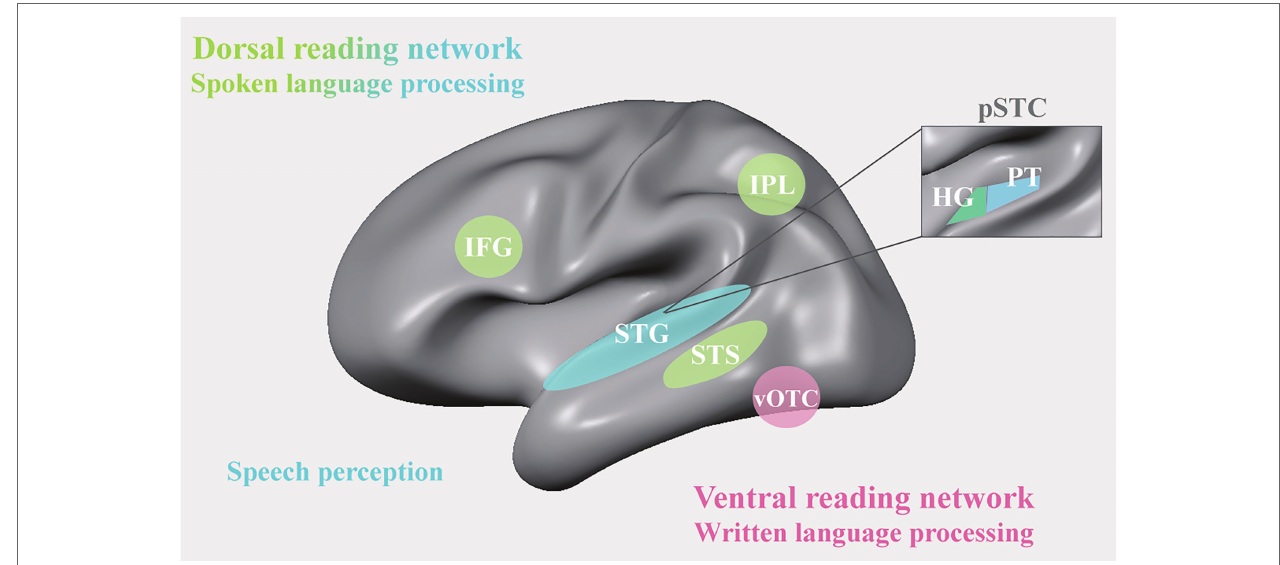
FIGURE 1 | A representation of the dorsal (green) and ventral (pink) reading networks of the brain’s audio-visual reading network. IFG: inferior frontal gyrus; IPL: inferior parietal lobe; STG: superior temporal gyrus; STS: superior temporal sulcus; vOTC: ventral occipito-temporal cortex; pSTC: posterior superior temporal cortex; HG: Heschl’s gyrus; PT: planum